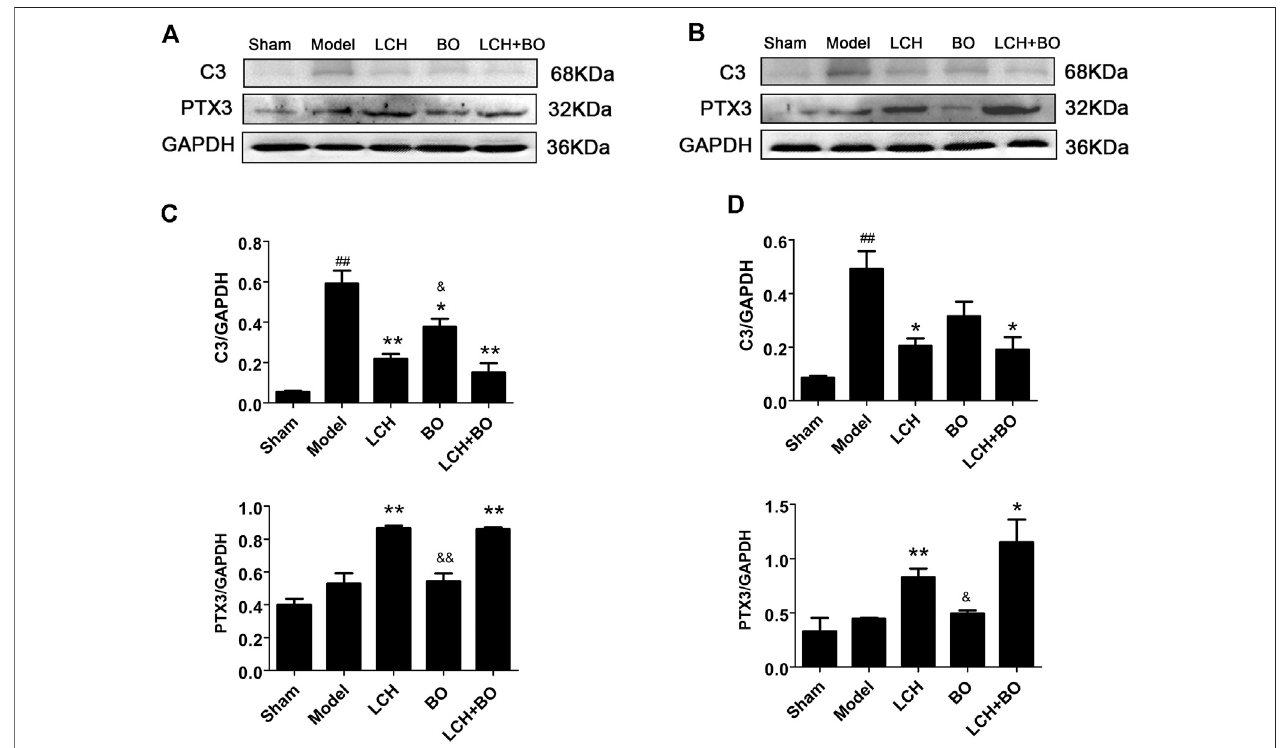
FIGURE 15 | Expressions of C3 and PTX3 within DG and SVZ of MCAO rats. (A) Blot images of the proteins in the DG area. (B) Blot images of the proteins in the SVZ area. (C) Relativeexpressions oftheproteins toGAPDHintheDGarea( n (cid:1) 3). (D) Relativeexpressionsoftheproteins toGAPDHintheSVZarea( n (cid:1) 3). ## p < 0.01 compared to the sham group; * p < 0.05, ** p < 0.01 compared to the model group; & p < 0.05, && p < 0.01 compared to the LCH + BO